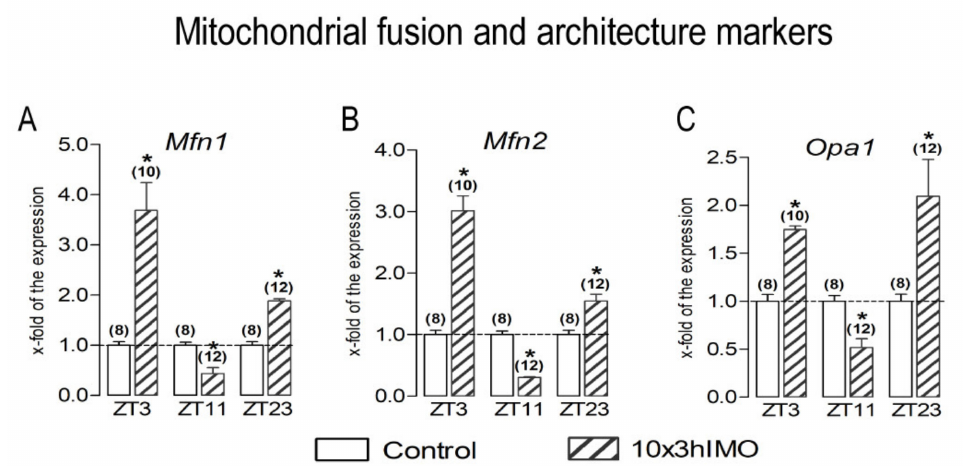
Figure 4. Different transcriptional profiles of mitochondrial fusion and architecture markers in spermatozoa of repeatedly stressed adult rats at different time points. Spermatozoa isolated from undisturbed and repeatedly stressed rats were used for RNA isolation and further analysis of the tran- scriptional profile of markers of mitochondrial fusion and architecture. Data bars are mean ± SEM values of two independent in vivo experiments (n = number of rats). Statistical significance was set at level p < 0.05: * vs. control group of the same time point.